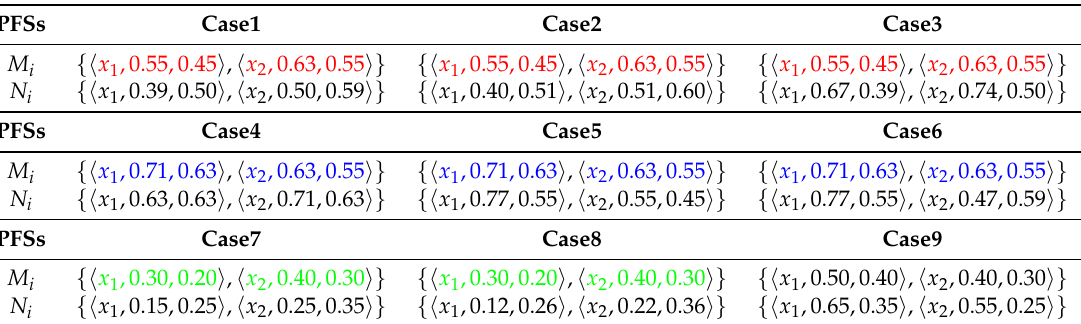
Table 1. Two PFSs M i and N i under different